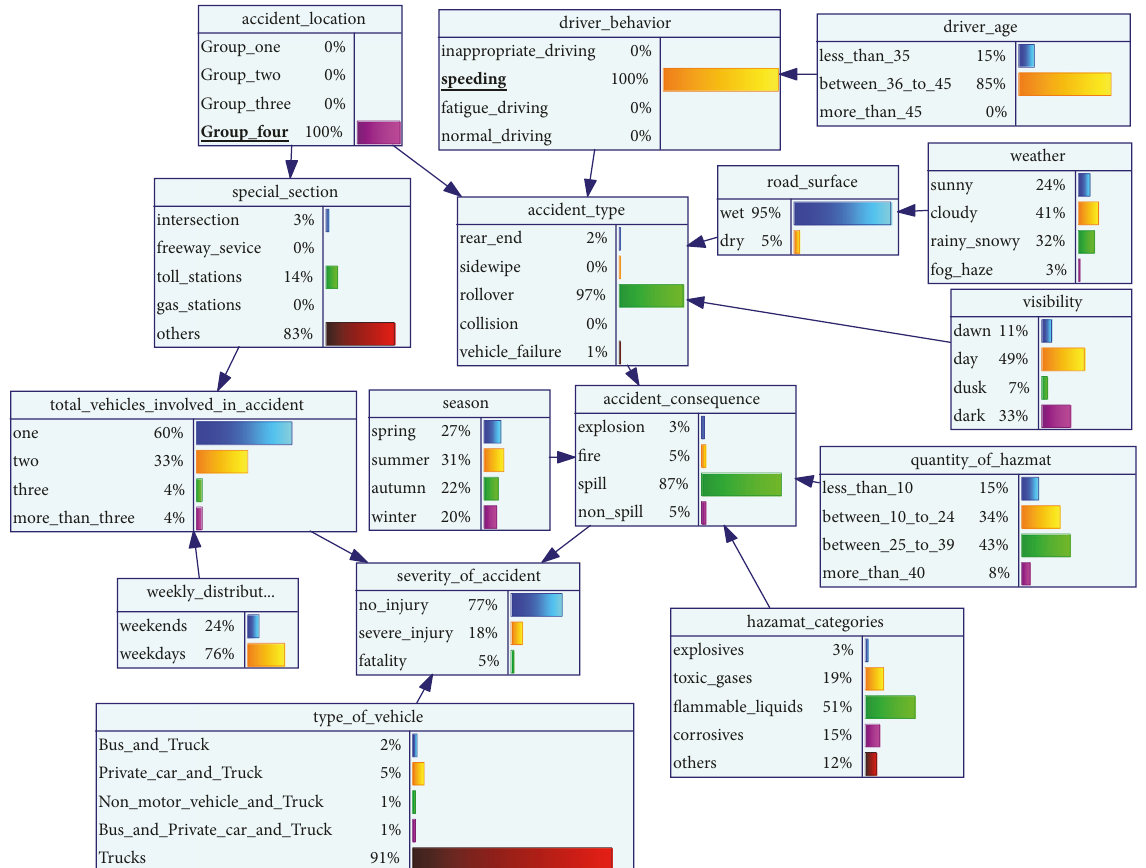
Figure 6: Accident prediction when the evidence variable are “speeding” and “Group